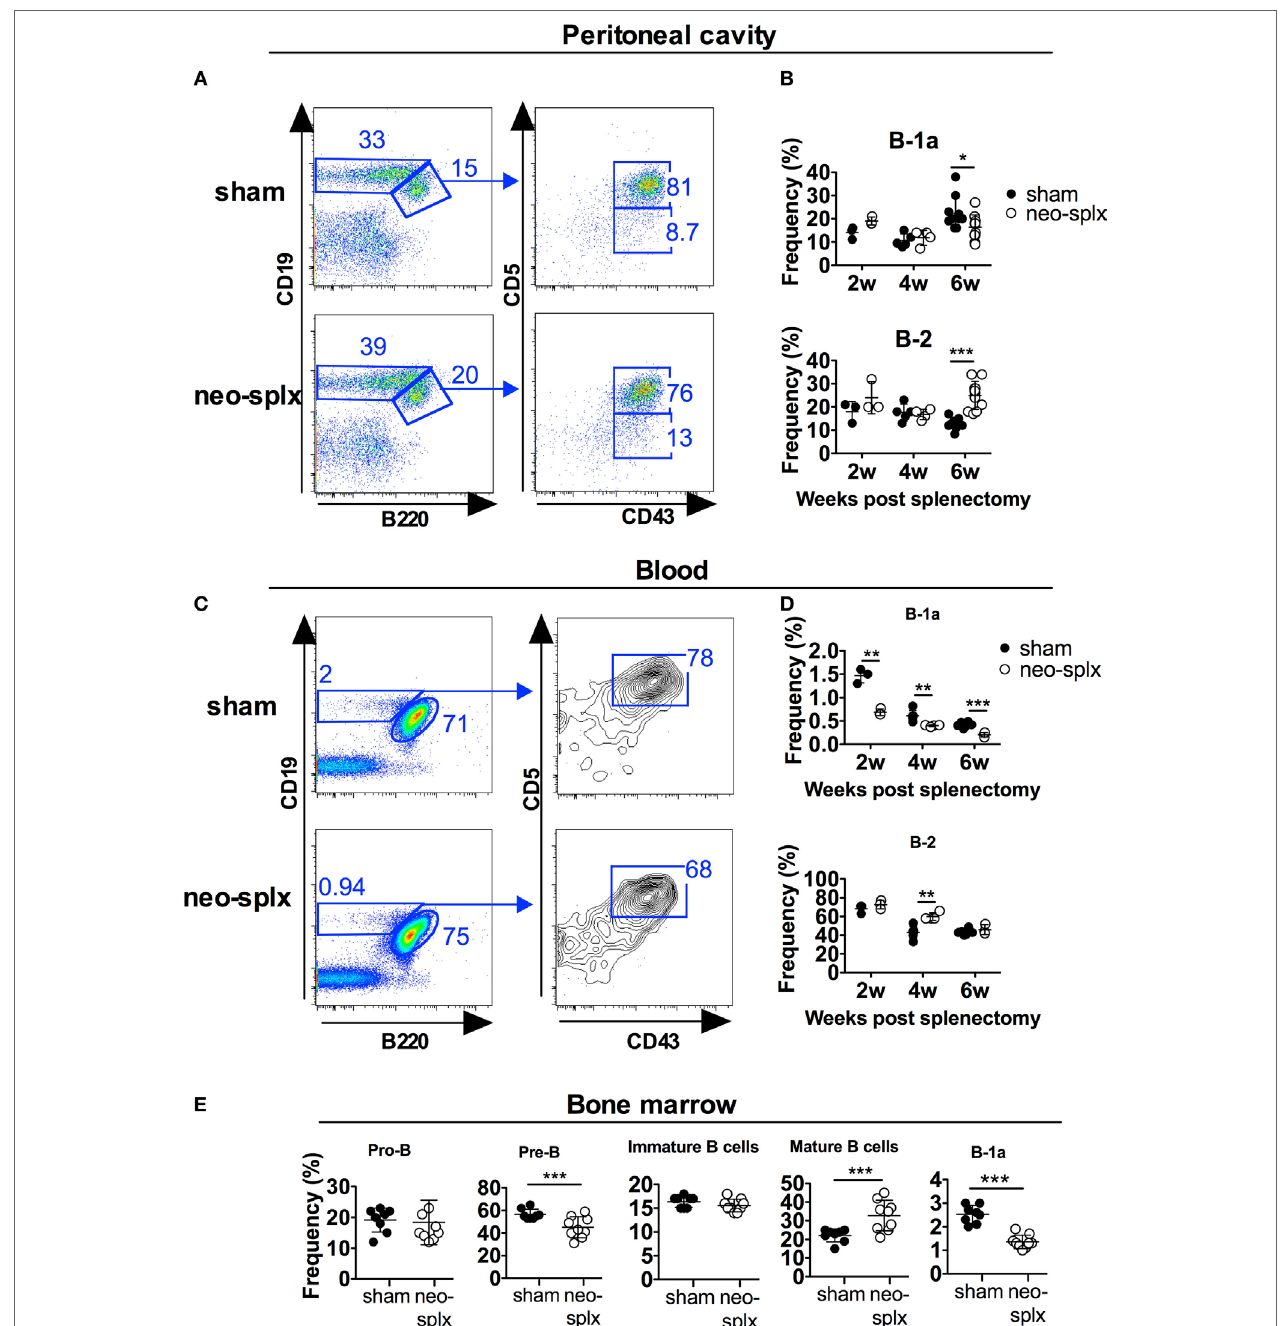
FigUre 3 | The neonatal spleen is not required for B-1a cell development but for maintaining normal B-1a cell frequencies. One-day-old wild-type pups underwent splenectomy (neo-splx) or sham surgery. Peritoneal B-1 cells were stained as defined as in Figure 1 . (a) Representative staining of 4-week-old mice. (B) Peritoneal B-1a, B-1b, and B-2 frequencies at 2, 4, and 6 weeks after neonatal splenectomy. Statistically significant differences are indicated by * and ***, denoting p < 0.05 and p < 0.001, respectively by unpaired t -test. (c) Representative staining showing blood B-1a cells in 2-week-old mice. (D) Blood B-1a and B-2 cell frequencies at 2, 4, and 6 weeks after neonatal splenectomy. (e) Bone marrow B-lineage populations defined as B220 + CD43 + CD19 + (pro-B), B220 + CD43 − CD93 + IgM − (pre-B), B220 + CD43 − CD93 + IgM + (immature B), B220 + CD43 − CD93 − IgM + (mature B), and CD93 − CD19hiB220loCD43 + CD5 + (B-1a) (Figure S3 in Supplementary Material). Results were pooled from several experiments with at least three mice per group assayed at each time point. Graphs display mean frequencies of the indicated cells in the lymphocyte gate ± SD. Statistically significant differences are indicated by *, **, and *** denoting p < 0.05, p < 0.01, and p < 0.001, respectively by unpaired t -test.